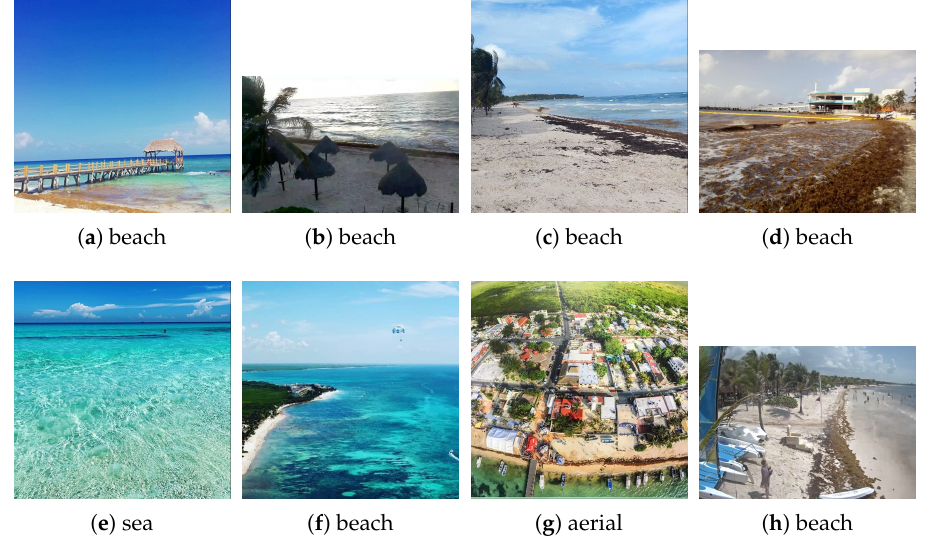
Figure 1. Image examples from the constructed dataset.